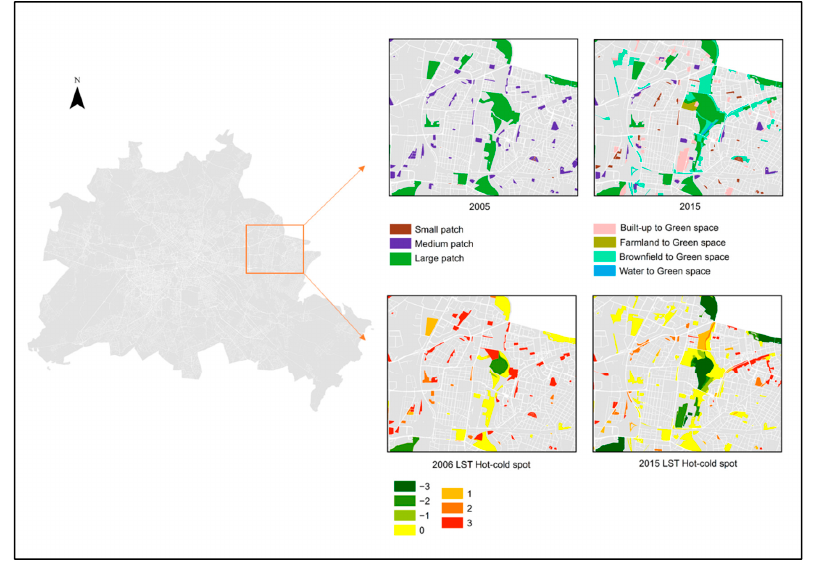
Figure 5. Additional green space in the northeast. Land 2021 , 10 , x FOR PEER REVIEW